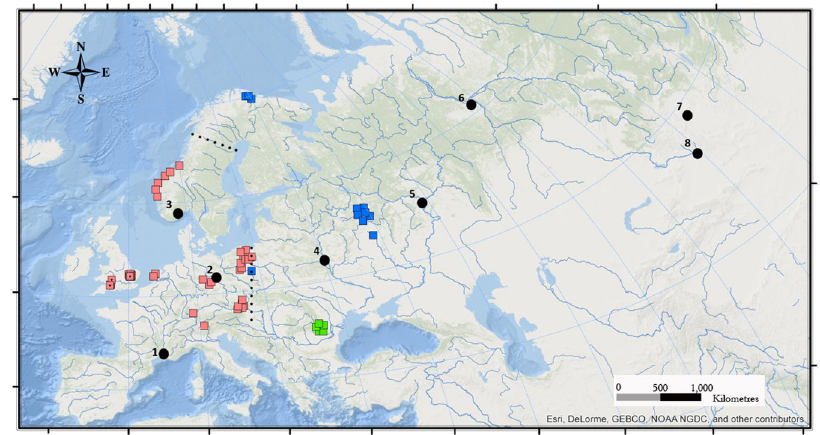
Figure 1. Map of sampling localities for ancient Castor fiber individuals. The Western clade (pink) and Eastern clade (blue) have two Holocene contact zones; one in Eastern Europe and one in NW Scandinavia. A now extinct clade existed in the Danube Basin (green) until the late Holocene 26 . Sampling localities for the British data are indicated with dotted square icons, all other points refer to those generated by Horn et al . 26 . Only localities from where successful sequences were retrieved are shown. These represented 17 specimens from the SW and SE of England (SI Table 2). Approximate locations of extant relict populations (1 to 8) from where modern C. fiber haplotypes derive are shown in black. Map created using ArcMap v10.5 , accessed at www.esri. com. Data was sourced from Natural Earth Data ,